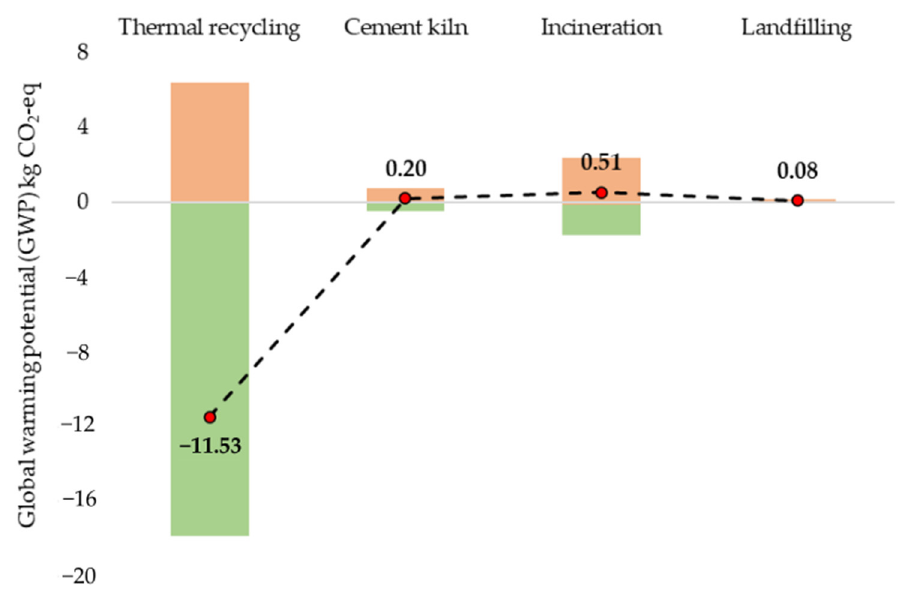
Figure 6. GWP of various CFRP waste disposal scenarios.